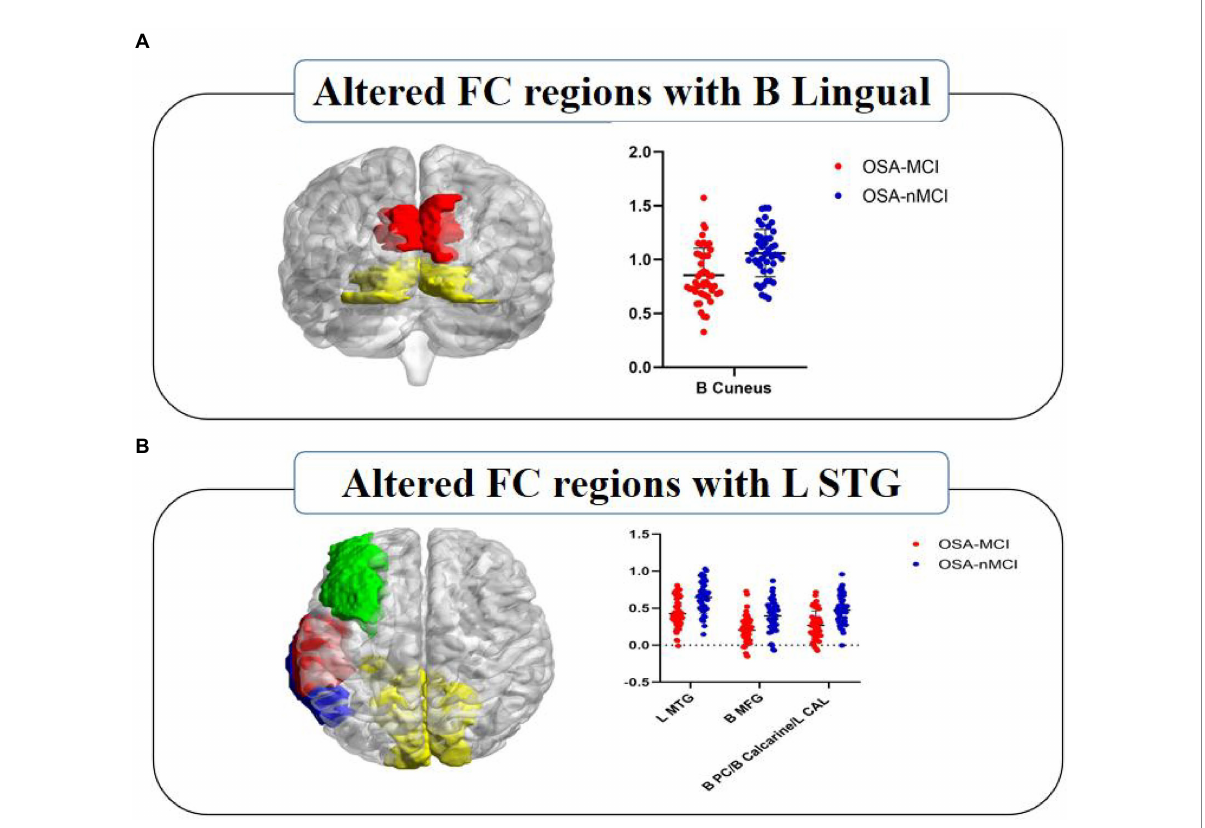
FIGURE 3 Significantly different FC values seeded as ROI in B-Lingual (A) and L-STG (B) . In figure (A) , red represents the lingual gyrus and yellow represents the cuneus; In figure (B) , red represents the left superior temporal gyrus, green represents the left middle frontal gyrus, blue represents the left middle temporal gyrus, and yellow represents the bilateral posterior cingulate/calcarine/left cerebellum anterior lobe. The FCs between significantly different regions and ROIs in OSA-MCI group was significantly reduced compare with OSA-nMCI group. L, left; B, bilateral; ROI, region of interest; FC, functional connectivity; STG, superior temporal gyrus; MTG, middle temporal gyrus; MFG, middle frontal gyrus; PC, posterior cingutate; CAL, cerebellum anterior